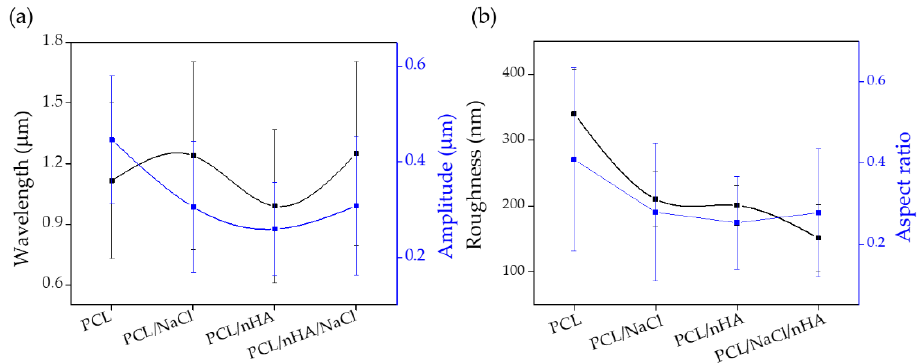
Figure 12. Results obtained by AFM of the net -poly(AAc- co -AMA) hydrogel deposited on the different PCL substrates: ( a ) Wavelength (black line) and amplitude (blue line) and ( b ) roughness (black line).